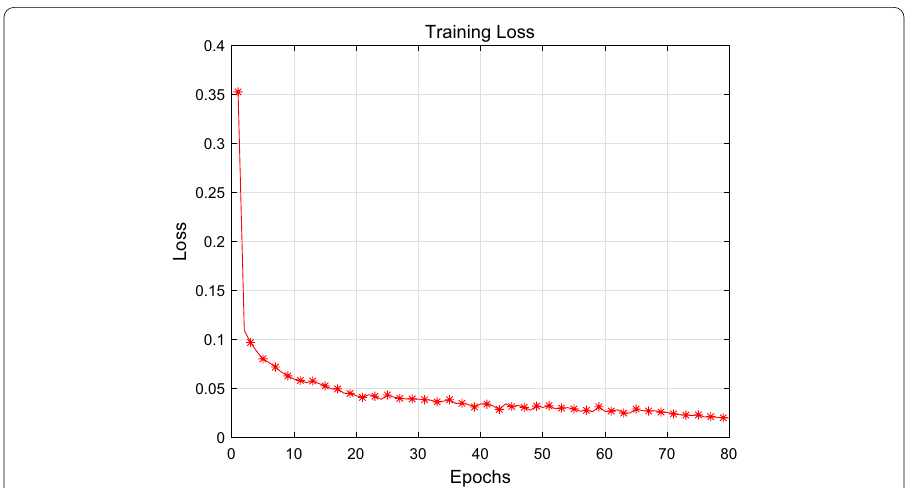
Fig. 10 Curve for L total of the proposed model as number of epochs increases during training